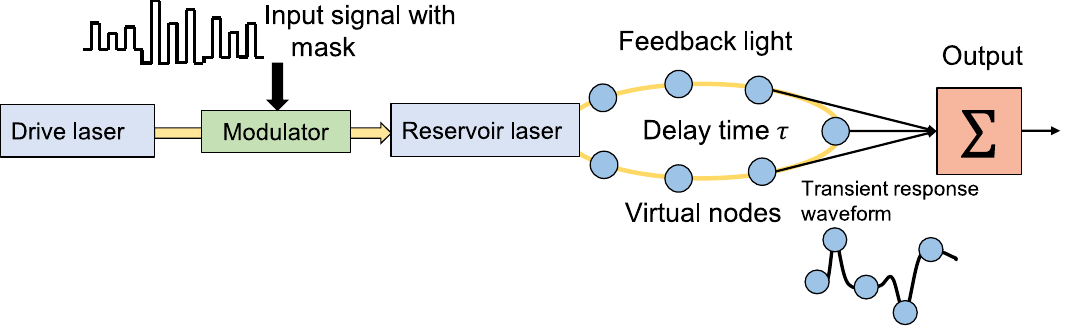
Figure 1: Reservoir computing using a semiconductor laser with optical feedback and